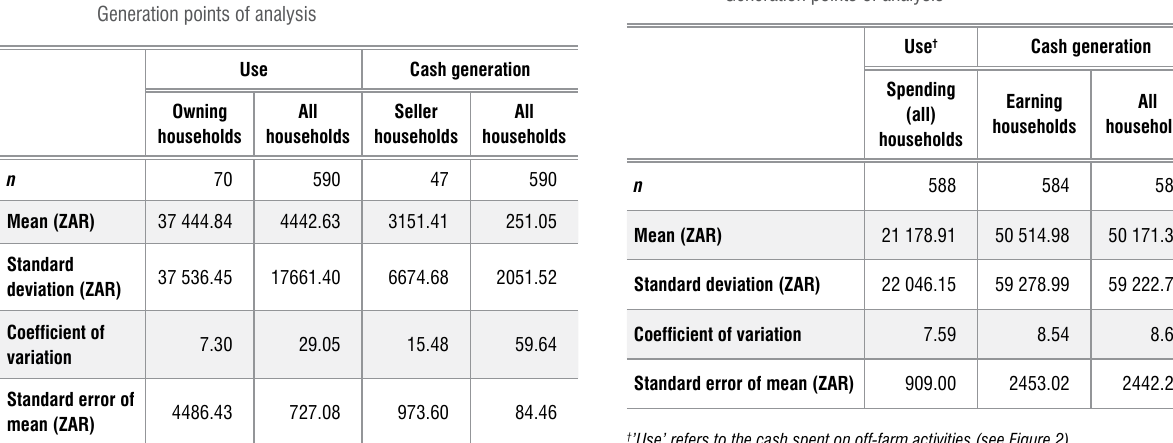
Direct use value of off-farm cash income at Use and Cash Generation points of